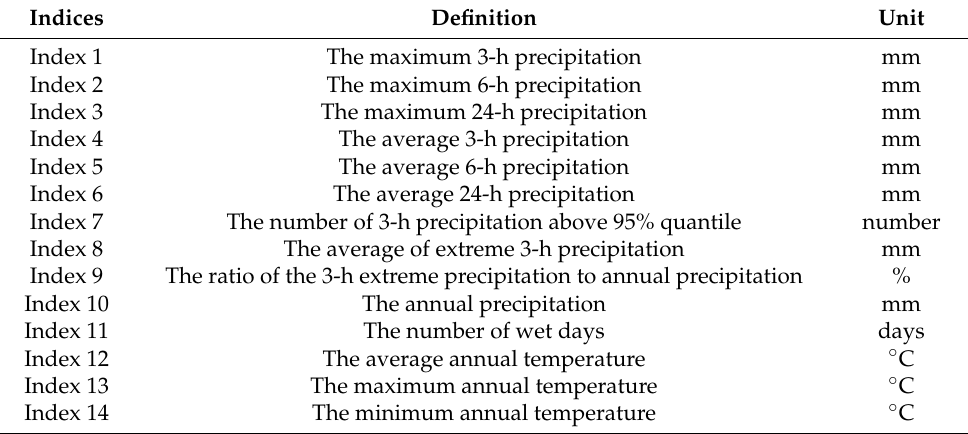
Table 2. The extreme rainfall indices and air temperature indices used for the trend analysis and their